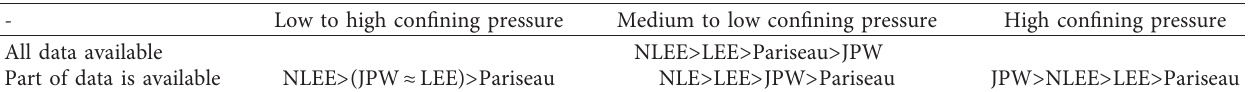
Figure 18: (a) The roof spalling around the roadway in 20 inclined layered roadway. (b) The bending deformation of reinforcing bars and shotcrete loss at the downstream sidewall of the crown in main powerhouse. Table 7: The order of the predictive accuracy of failure criteria under different